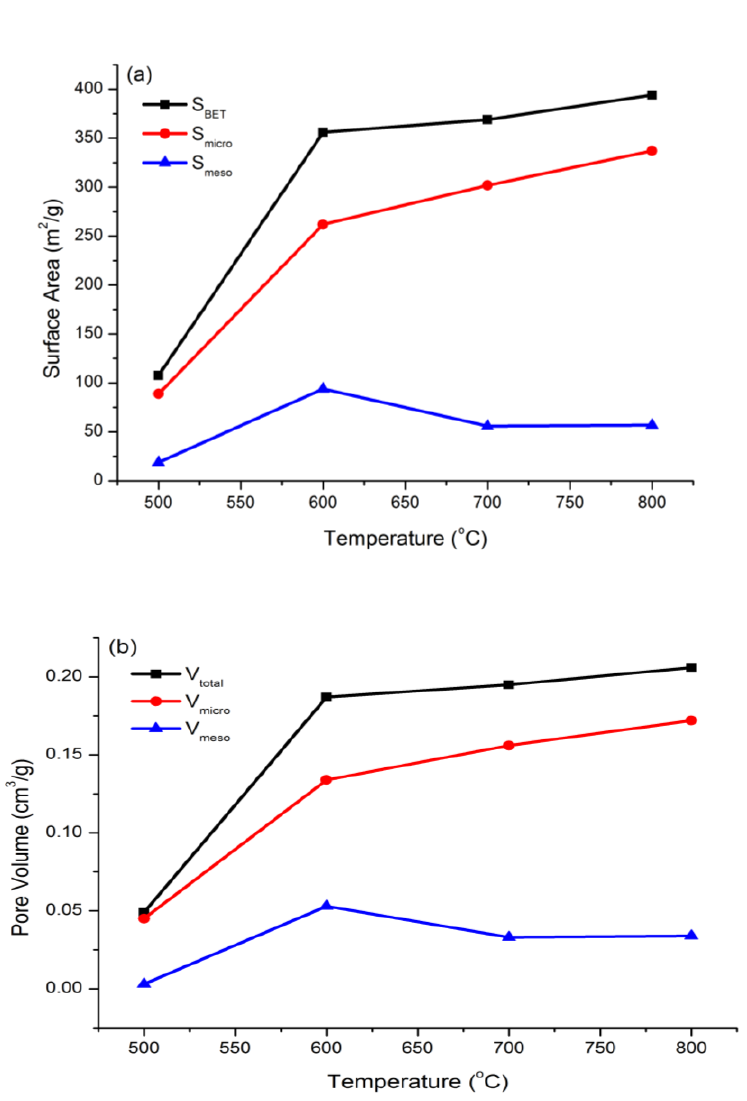
Figure 5. Effect of carbonization temperature on ( a ) surface areas and ( b ) pore volumes of AC samples at different carbonization temperatures.